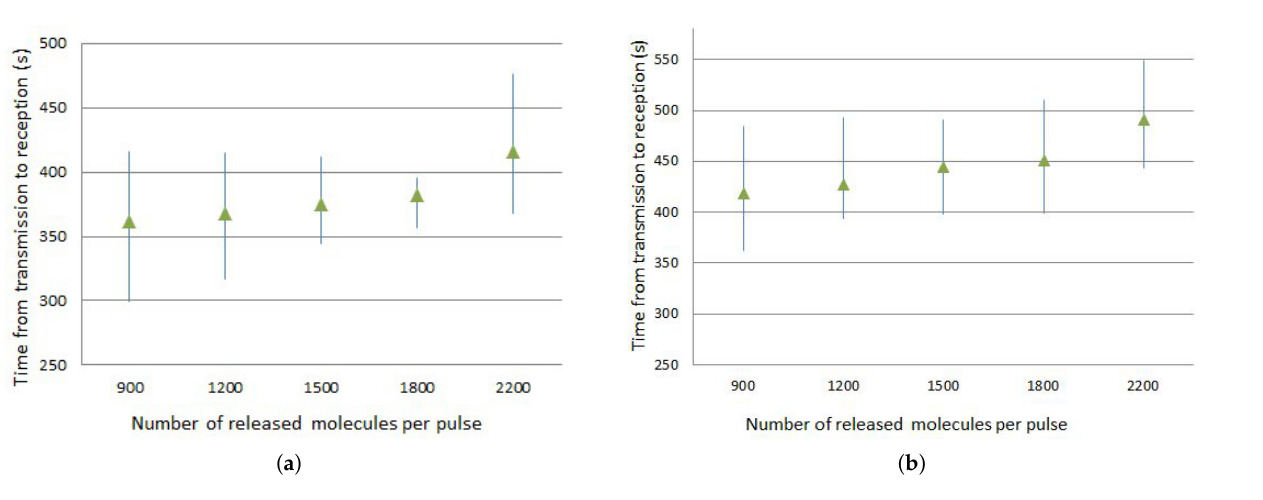
Figure 6. Reception performance for different distances between BS and node (150 µ m ( a ), 300 µ m ( b )). ( a ) Time-on-air deviation for the system. Increasing the number of molecules results in more consistent receptions. ( b ) Time-on-air deviation for the system with increased distance (300 µ m). Higher concentration pulses demand more time to be